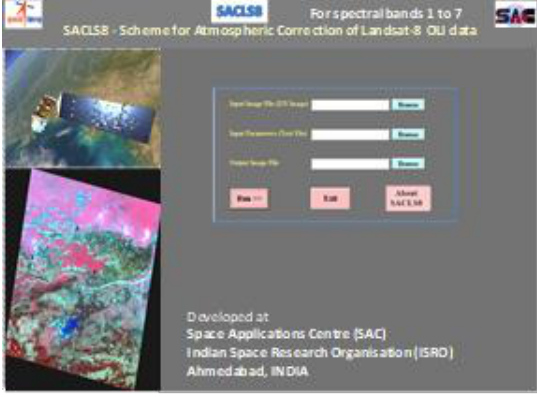
Figure 3: Snapshot of a GUI based SACLS8 model.